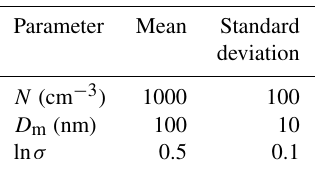
Table 1. Mean and standard deviation of the size distribution pa- rameters of the non-volatile particles.